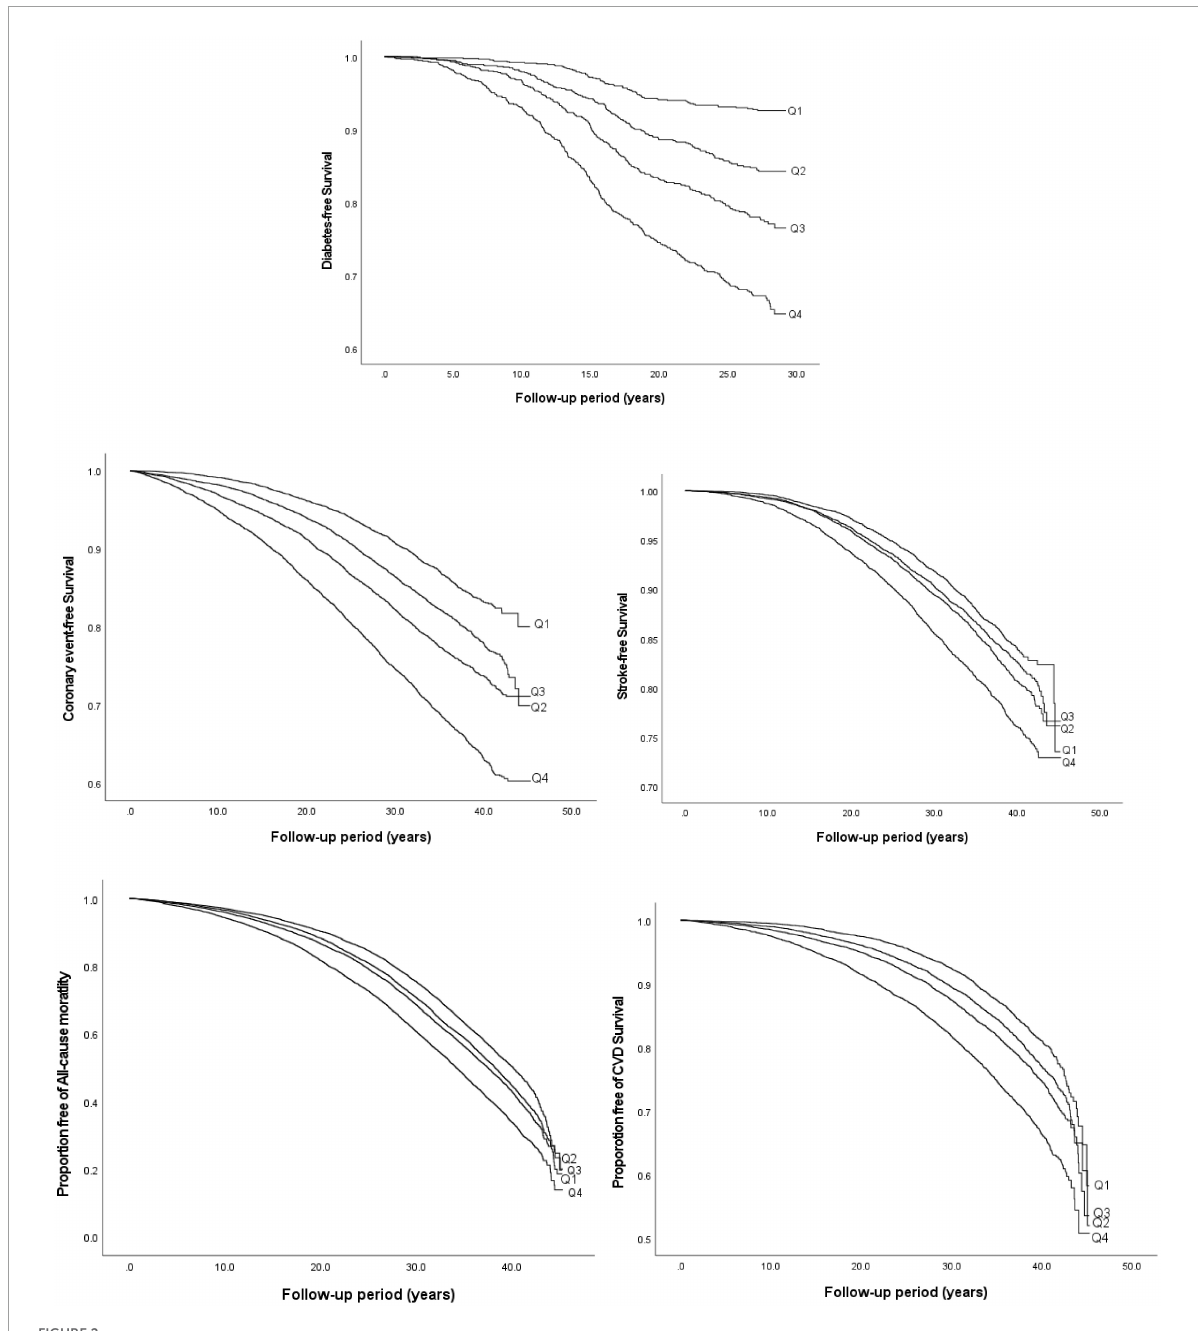
FIGURE2 Kaplan–Meier curves of incident diabetes, CVD, all-cause, and cardiovascular mortality by quartiles of TyG index.